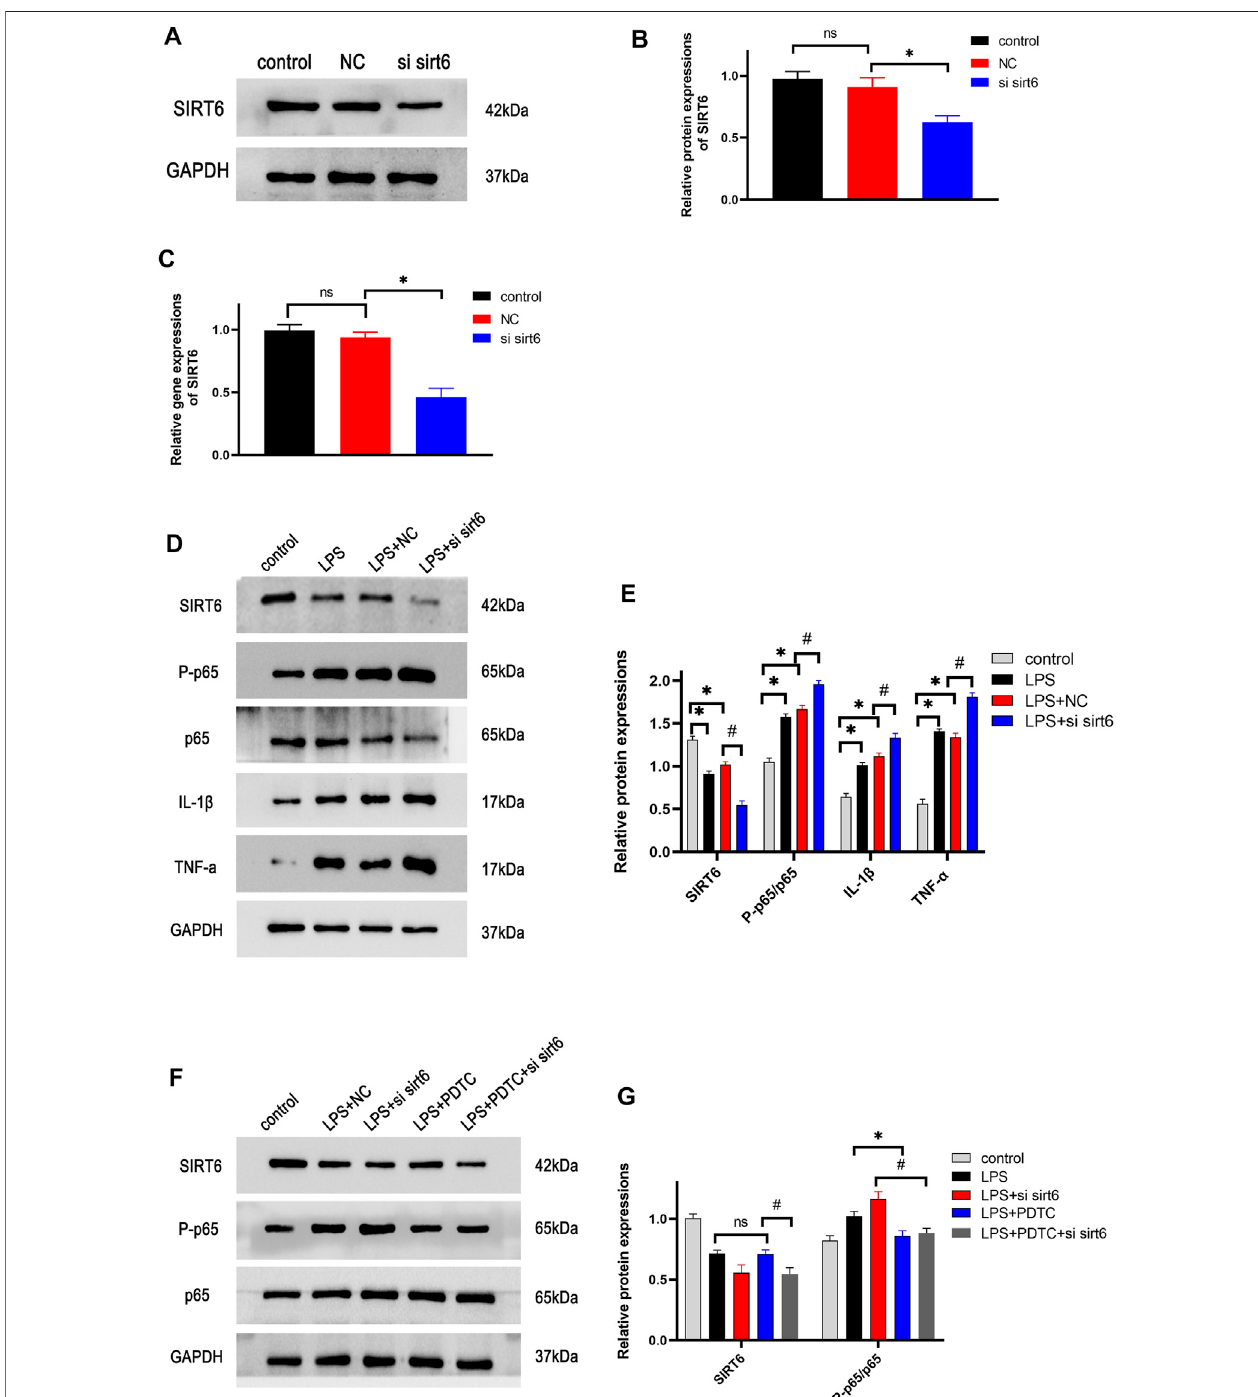
FIGURE7| EffectsofknockdownofSIRT6ontheNF- κ BpathwayinLPS-inducedRAW264.7cells. (A) AftersiRNAtransfectionfor24 h,thetransfectionef fi ciency of cells was detected by Western blotting (B) and RT-PCR (C) . (D) Cells were treated with siRNA and LPS, and the NF- κ B pathway proteins were investigated by Westernblotting. (E) Densitometricanalysisofproteins. (F) NF- κ Binhibitor,50 μ MPDTCwasaddedincells,thepathwayproteinexpressionwasanalyzedbytreatment with siRNA and LPS. (G) Densitometric analysis of proteins. * p < 0.05, compared with the control group. # p < 0.05, compared with the model group. n = 3 per group. Data are represented as mean ±